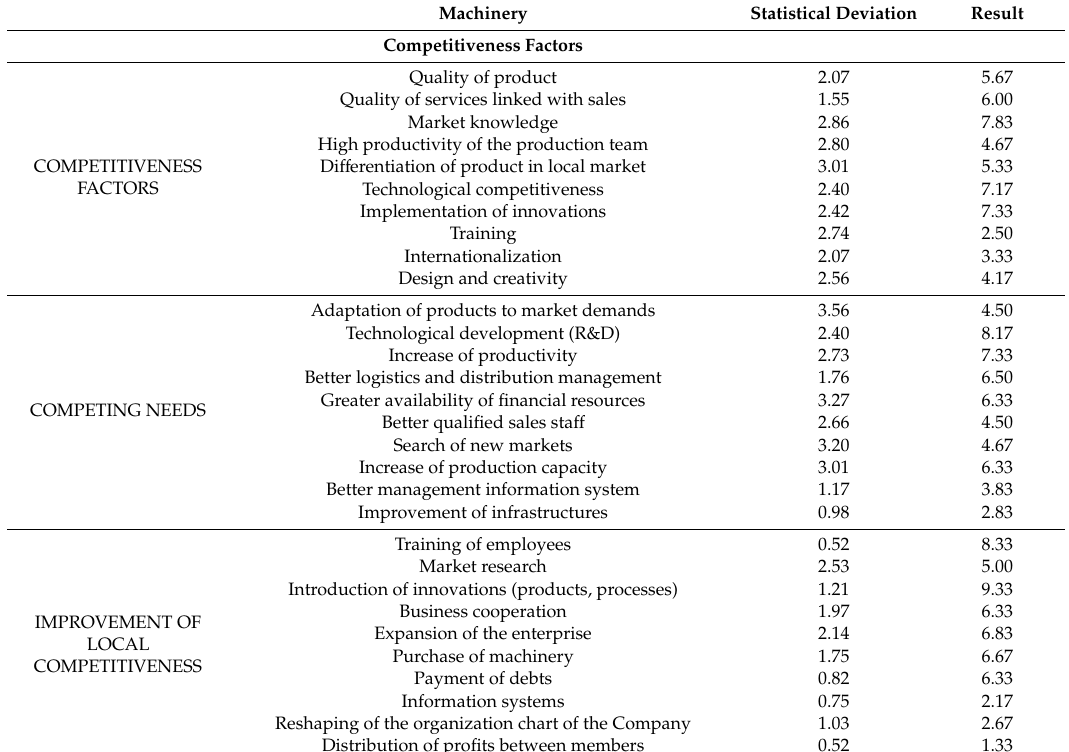
Table A2. Results and Statistical Deviation: Machinery